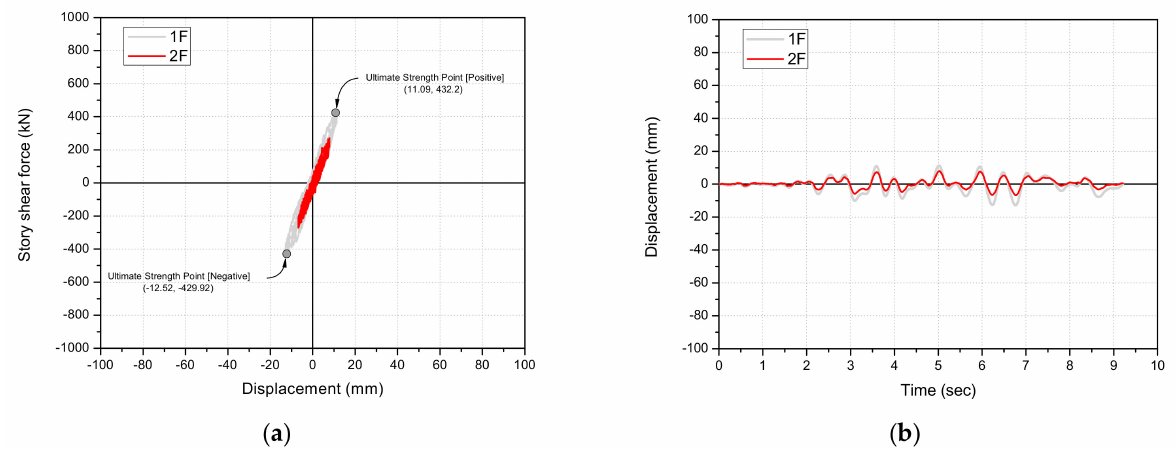
Figure 15. Seismic response load-displacement and displacement-time hysteresis curves (PD-CFT-MF, 200 cm/s 2 ): ( a ) load- displacement curves; ( b ) displacement-time hysteresis curves.